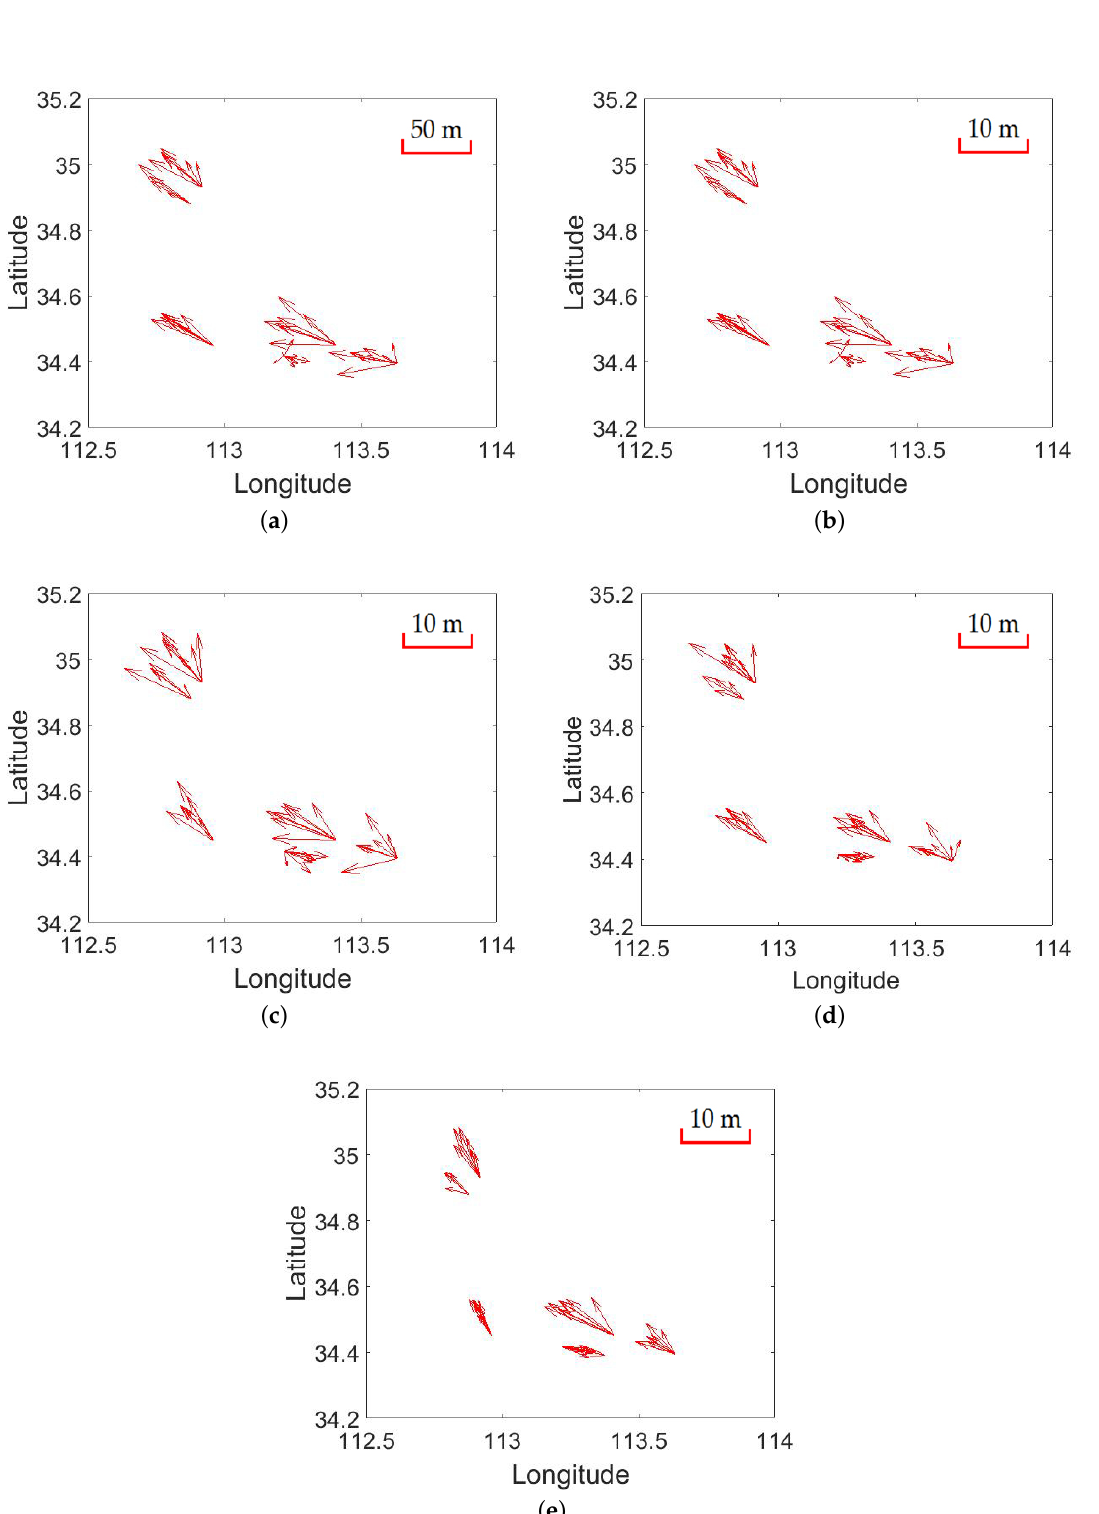
Figure 8. Error distribution of the test dataset with different weight strategies. ( a ) is the error distribution before block adjustment; ( b ) is the error distribution after the block adjustment procedure with weight strategy 1; ( c ) is the error distribution after the block adjustment procedure with weight strategy 2; ( d ) is the error distribution after the block adjustment procedure with weight strategy 3 and ( e ) is the error distribution after the block adjustment procedure with weight strategy